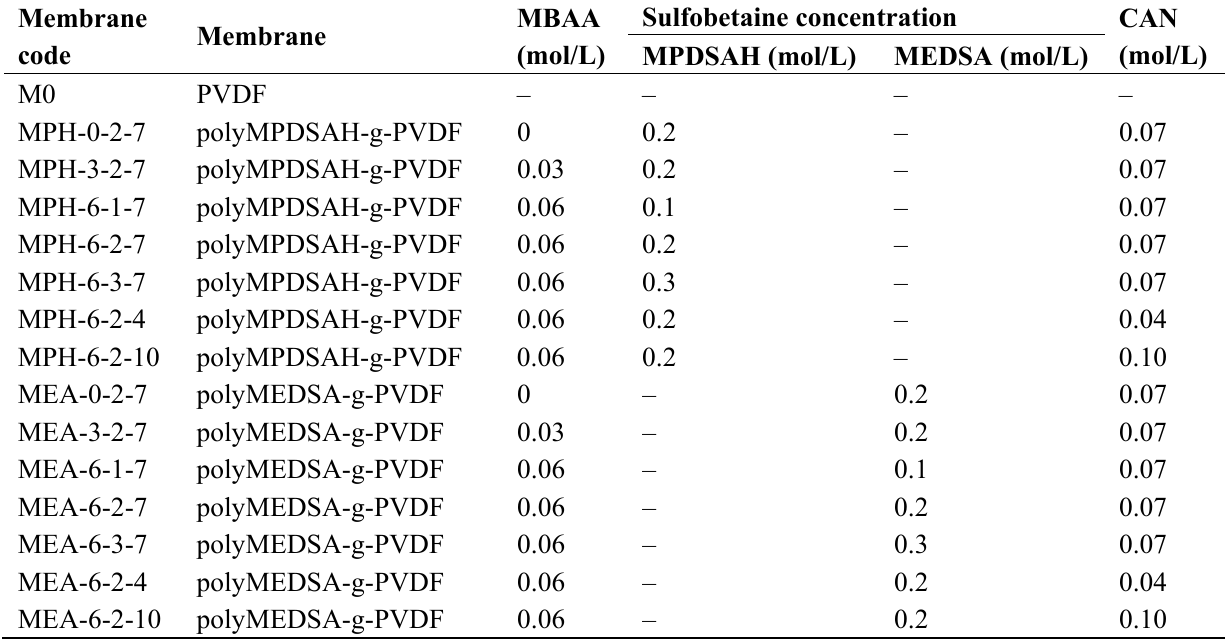
Table 4. Preparation conditions of various